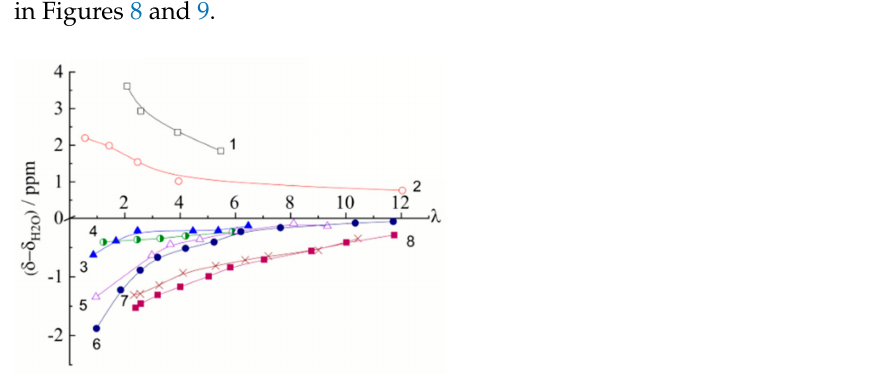
Figure 8. Chemical shift ( δ ) differences between water protons in the membrane and in bulk water as a function of the moisture content of MF-4SC (1–4) and F-4CF (5–8) membranes in various ionic forms. Membrane ionic form: (1, 5) H + , (2, 6) Li + , (3, 7) Na + , (4, 8) Cs + . Reprinted with permission from [20]. Copyright 2011